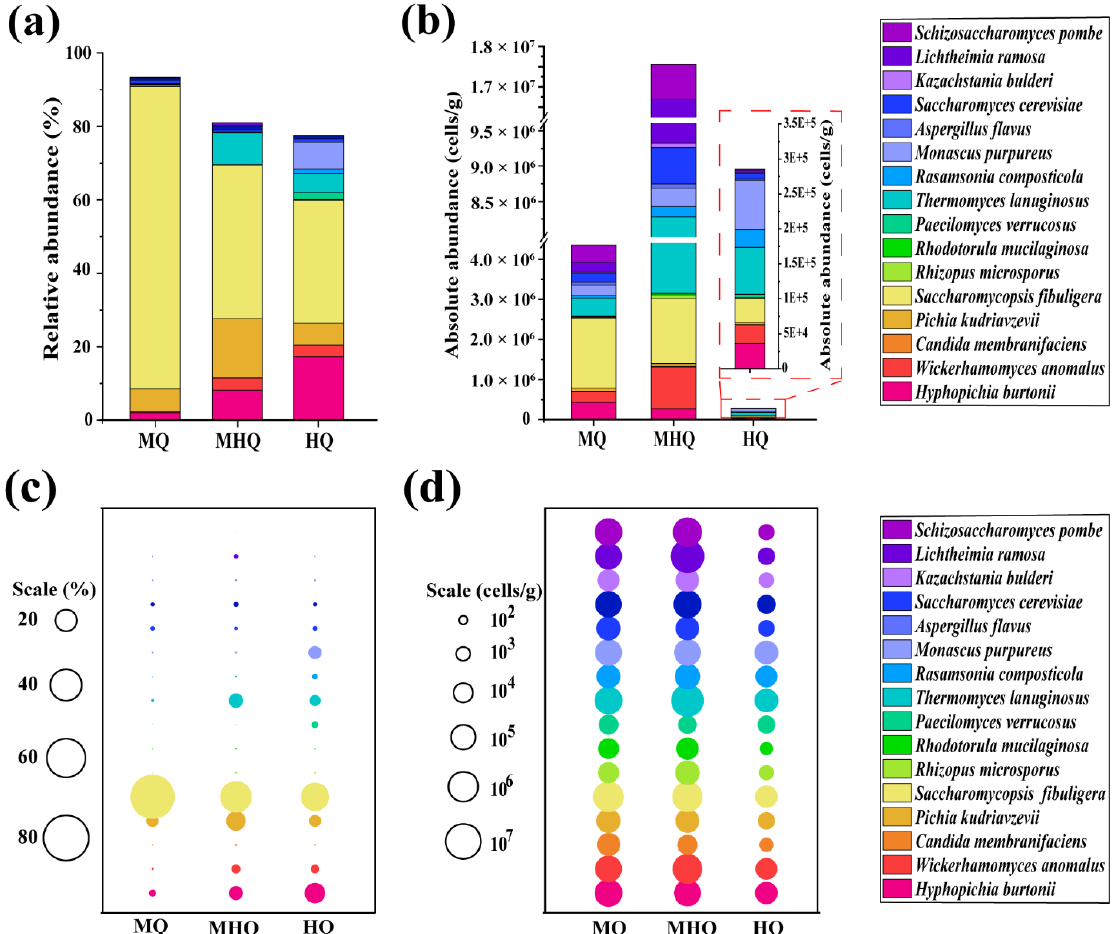
Figure 7. Comparison of the relative and absolute abundance of 16 core fungi. ( a , c ) Relative abun- dance of 16 core fungal communities in mature Daqu at the species level. ( b , d ) Absolute abundance of 16 core fungal communities in mature Daqu at the species level.